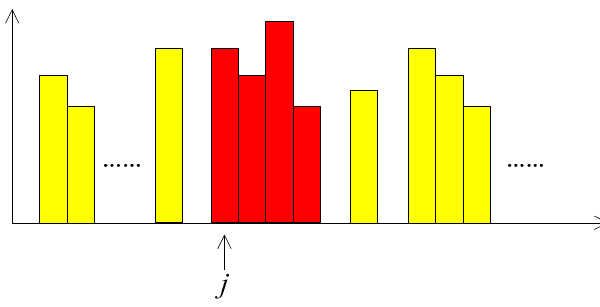
Figure 2. Continuum of histogram column gaps.